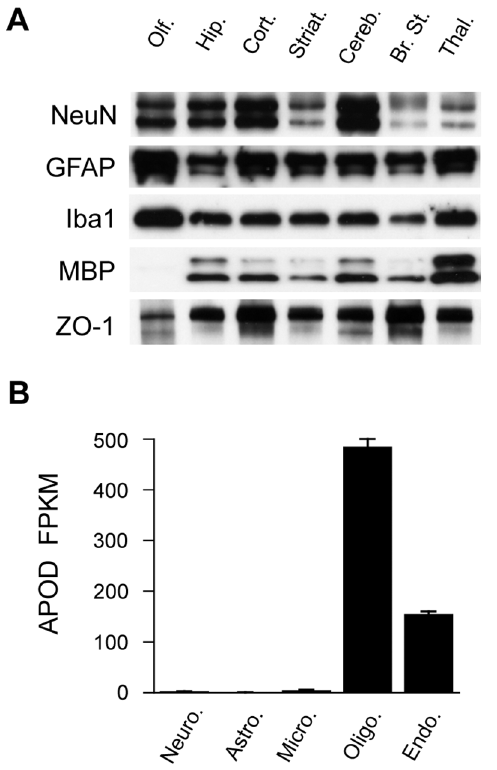
Fig 2. Expression of cell type marker proteins in mouse brain regions. The indicated regions of mouse brain were homogenized and assessed for listed cell specific markers by western blotting after controlling for equal total protein loading. Representative blots are shown from an ~8 month-old male mouse (A). The histogram indicates the predicted relative expression levels of apoD mRNA in various brain cell types (B). Fragments per kilobase of exon per million fragments mapped (FPKM) data are mean values, (SE shown by the error bars) derived from the publically available data based described by Zhang et al . (see reference [40]). Olf., olfactory bulb; Hip., hippocampus; Cort., frontal cortex; Striat., striatum; Cereb, cerebellum; Br. St., brain stem; Thal., thalamus/hypothalamus; NeuN, neuronal nuclei; GFAP, glial fibrillary acidic protein; Iba1, ionized calcium-binding adapter molecule 1; MBP, myelin basic protein; ZO-1, zonula occludens protein 1.